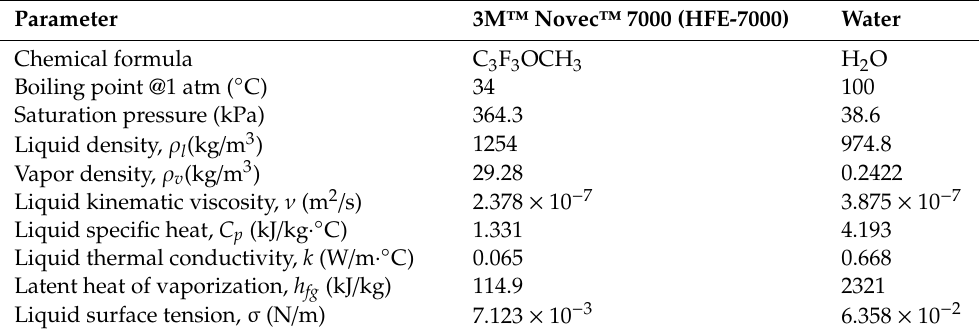
resistance of the PHP distributed over a wide range between 9.5 and 0.02 °C/W, depending on the selection of working fluid, the tube material, tube diameter, and the heating power.